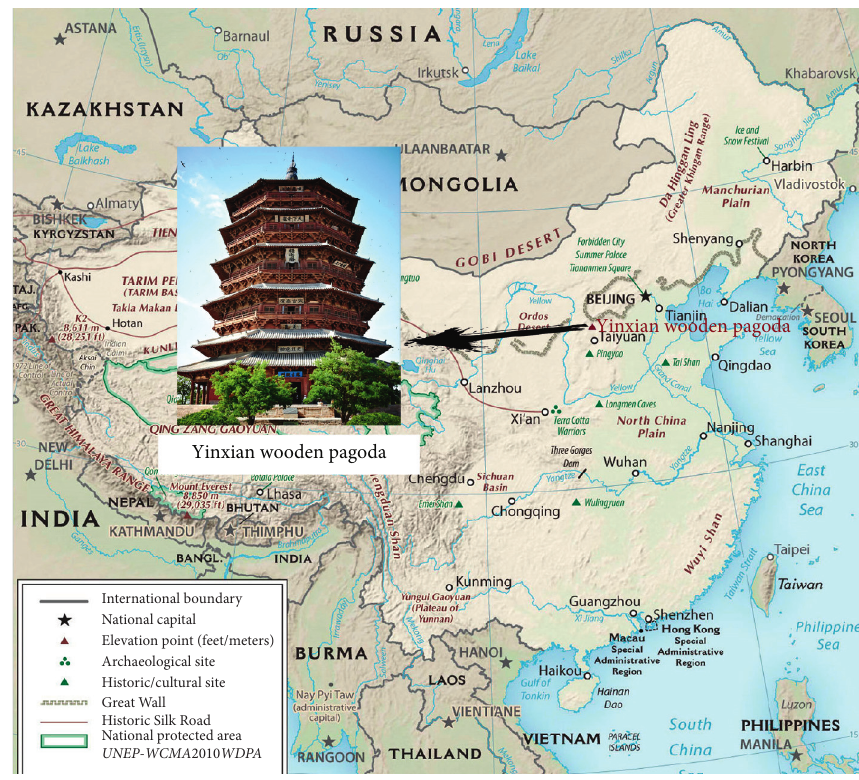
Figure 1: Map showing the location of Yingxian Wood Pagoda.